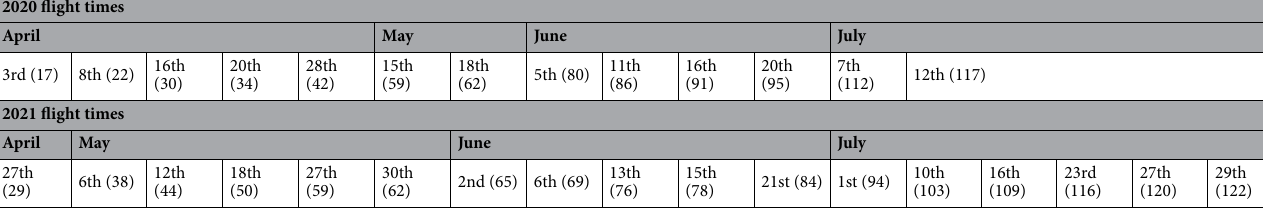
Data extraction from remotely sensed images. Populations of interest were assessed using QGIS QGIS using UAStools such that all plots were labeled according to range, row, and hybrid based on field maps for the 2020 and 2021 growing seasons 25 . Vegetation indices (VIs) were extracted using the FIELDimageR